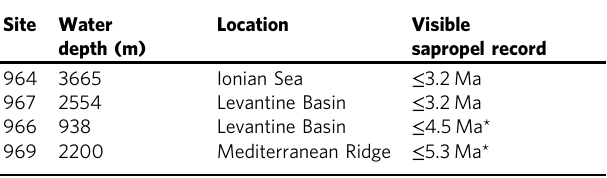
Table 1 Sapropel preservation at Eastern Mediterranean ODP sites 29